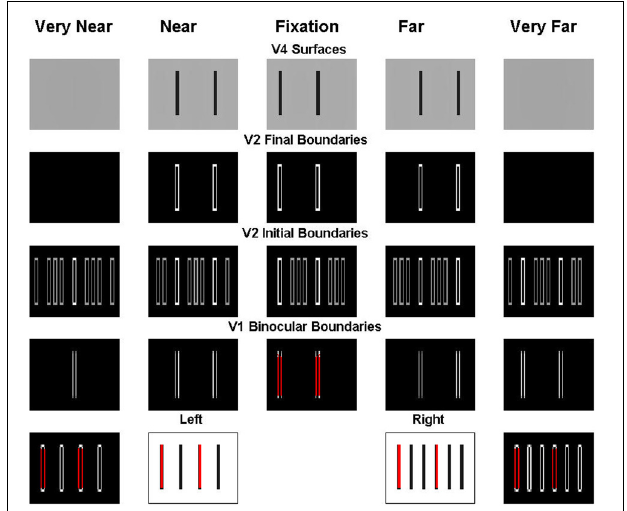
FIGURE 7 | Explanation of the simulation of the Venetian blind effect where the bars in retinal correspondence and their binocular fusion in the fixation plane are marked in red. See the caption of Figure 6 for an explanation of the variables being simulated, and the text for further details.